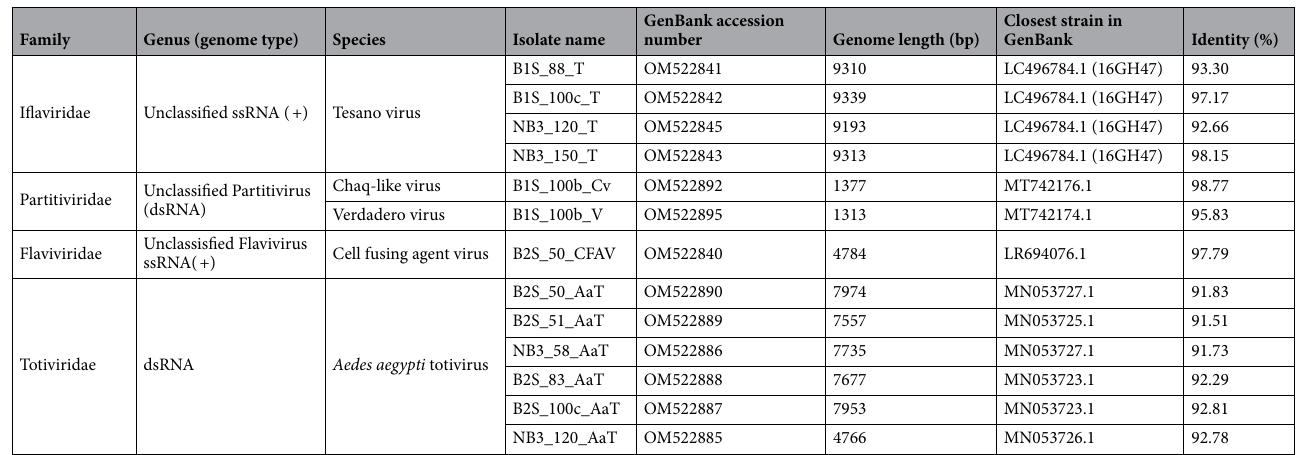
Table 4. Assembly and Genome characterization of members of Iflaviridae , Partitiviridae , Flaviviridae and Totiviridae described in this